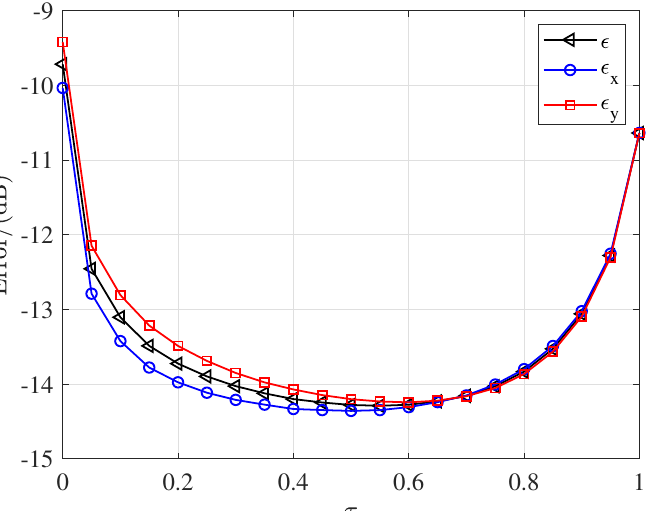
Figure 2. The NMSE of the reproduced intensity at control points with different tuning parameter τ . The reverberation time RT 60 = 200 ms and the control filter length J =